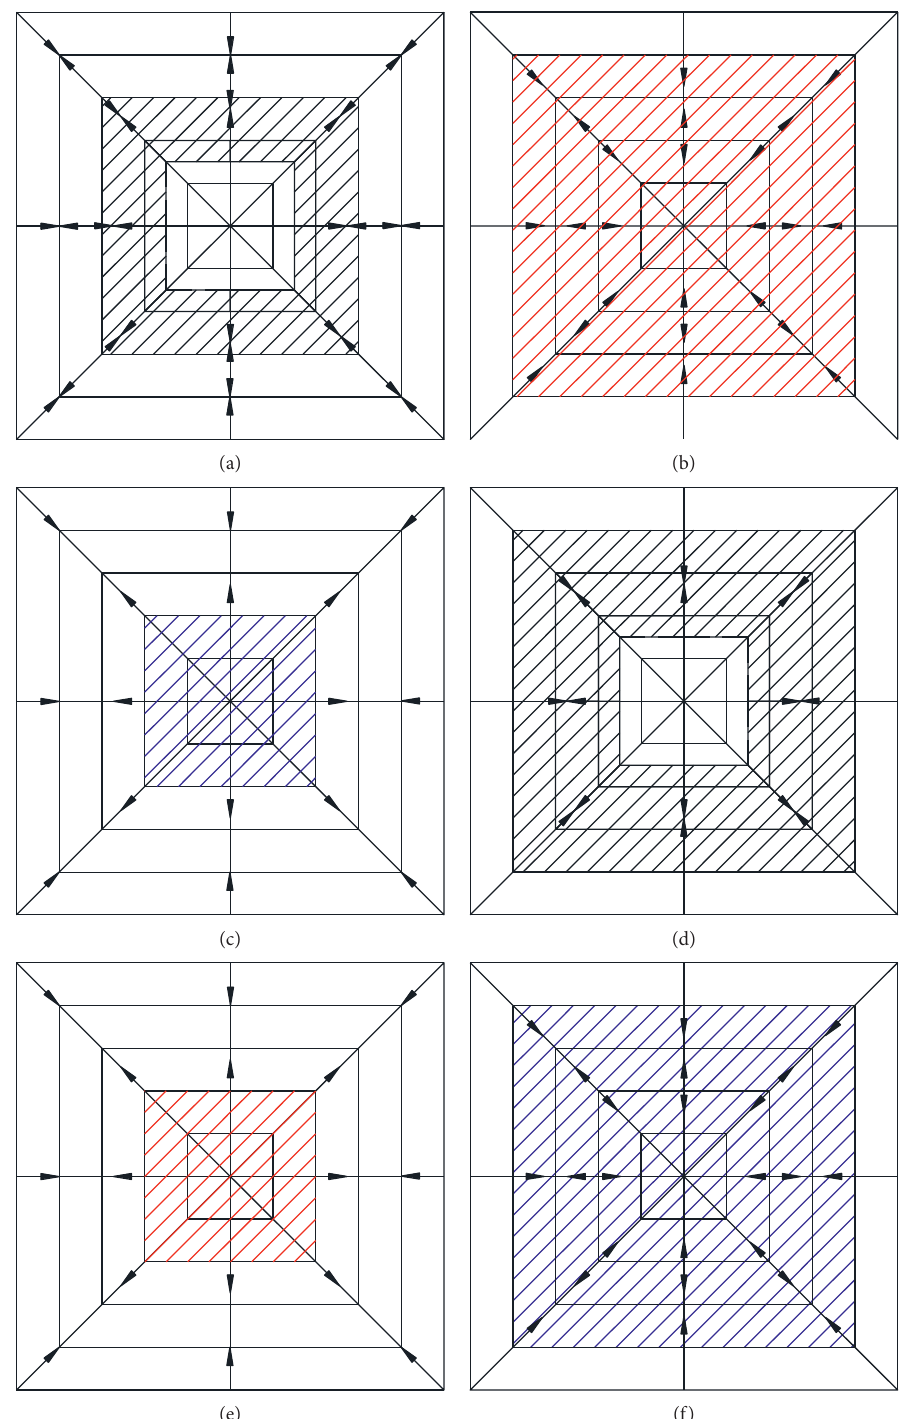
Figure 9: Developments of cross/longitudinal-section damages and severe damage areas of different freeze-thaw damage models. (a) Z- grade of 4.8% asphalt-aggregate ratio. (b) Z-grade of 5.3% asphalt-aggregate ratio. (c) Z-grade of 5.8% asphalt-aggregate ratio. (d) S-grade of 4.8% asphalt-aggregate ratio. (e) S-grade of 5.3% asphalt-aggregate ratio. (f) S-grade of 5.8% asphalt-aggregate